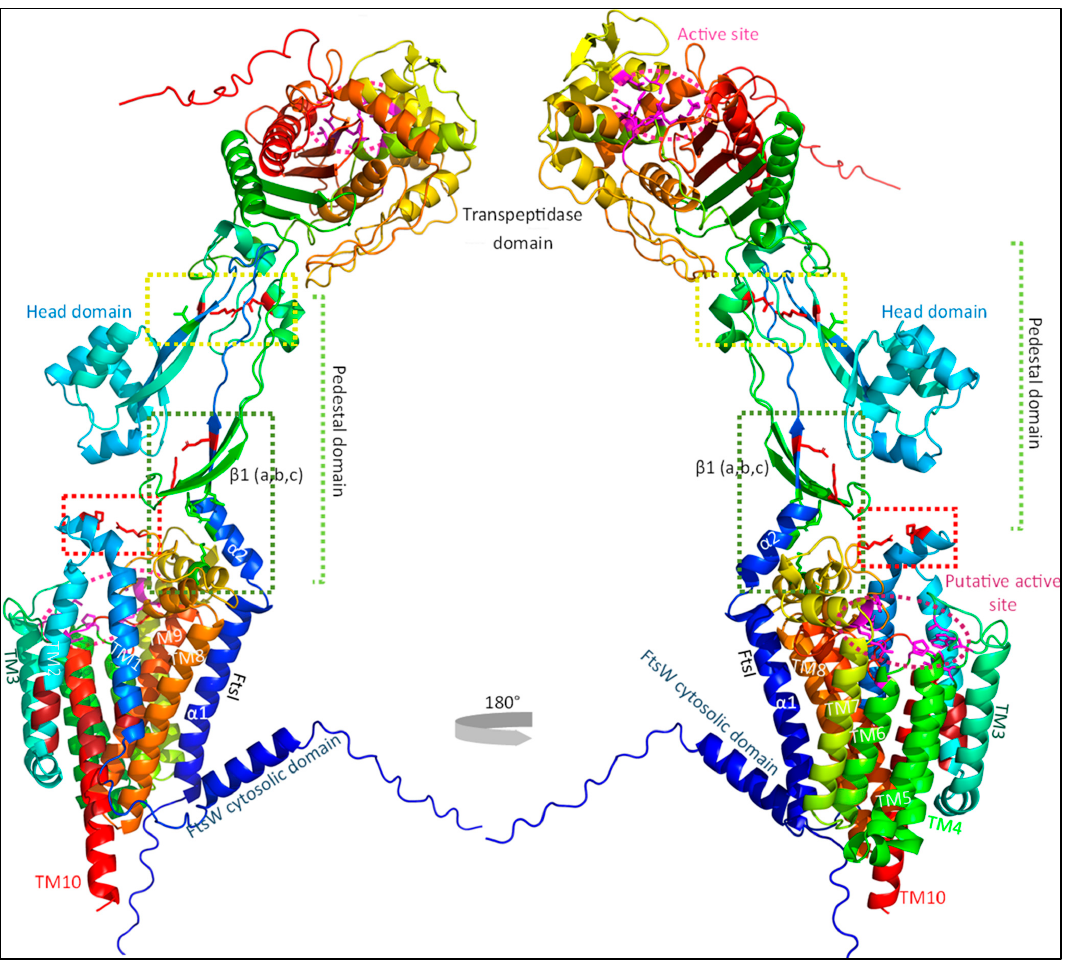
Figure 3. The FtsWI peptidoglycan synthesizing holoenzyme. FtsI consists of a short cytoplasmic domain, a transmembrane domain ( α 1), a pedestal domain (including head domain) and a C- terminal transpeptidase domain. FtsW comprises a collection of 10 transmembrane domains (TM1-10) which are connected by periplasmic and cytoplasmic loops. Multiple regions that control the activity of FtsWI are indicated by the colored boxes and detailed further in Figures 3 and 4. Although no crystal structure of the FtsWI is available, predictions of the structure have been produced with AlphaFold2 advanced and visualized with the PyMOL Molecular Graphics System, Version 2.5.2 Schrödinger, LLC. Sequences for the prediction were obtained from the UniProtKB database (P0ABG4-1 for FtsW and P0AD68-1 for FtsI).